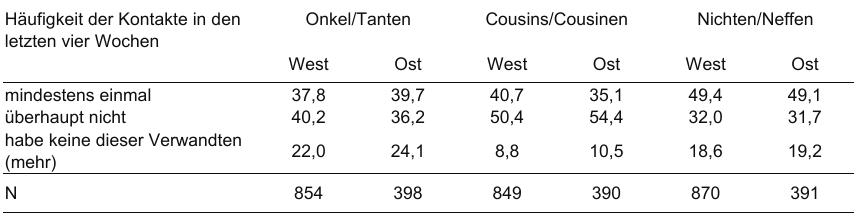
Tab. 1: Kontakte mit dem erweiterten Familienkreis in den letzten vier Wochen (Angaben in Prozent)